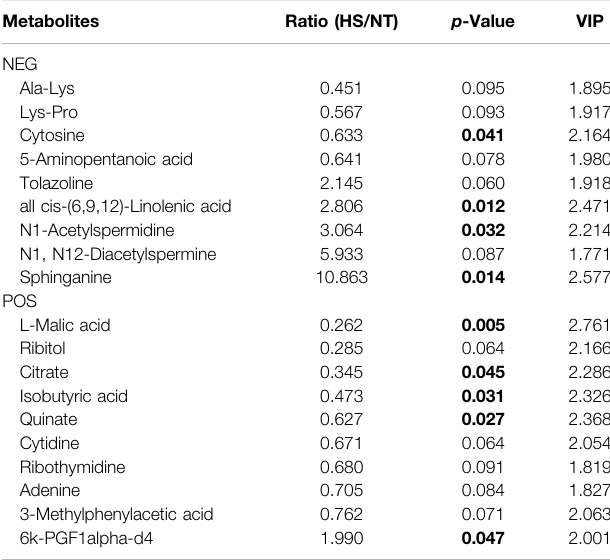
TABLE 5 | Effects of heat stress on cecal differential metabolites in indigenous broilers.